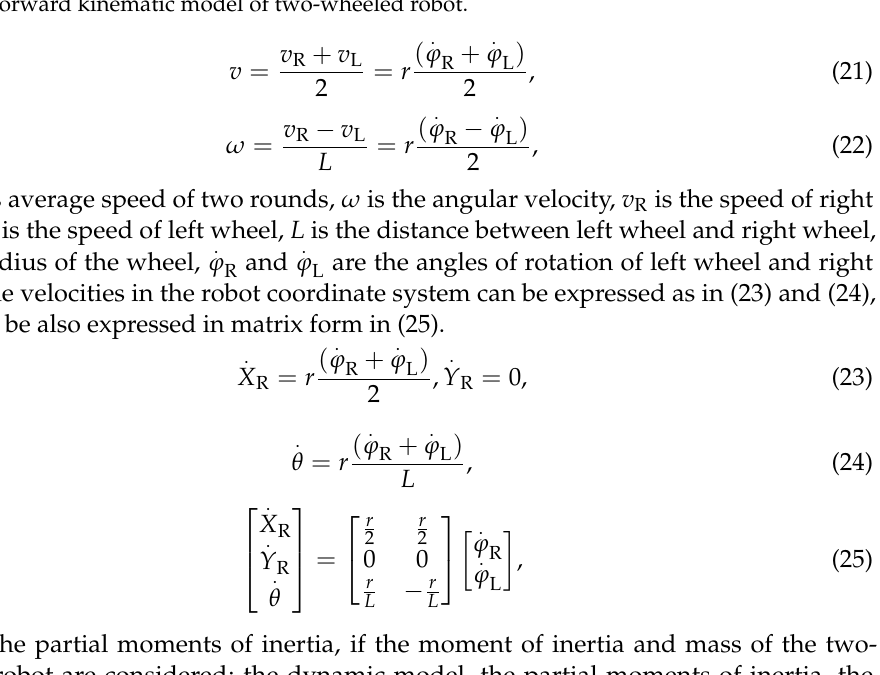
Figure 7. Forward kinematic model of two-wheeled robot.